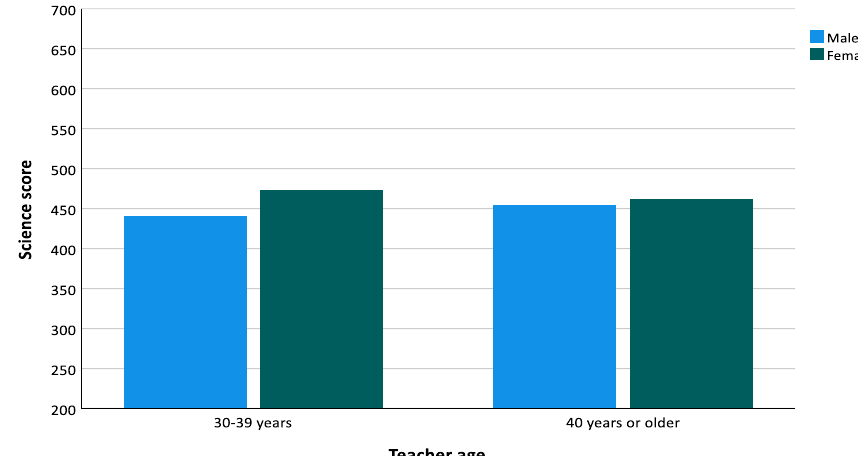
Fig. 10 Interaction between gender and teacher age on science achievement, grade 8. The plot presents the predicted values from step 7 of the science model for grade 8 (Table 11). Only the reference category and the category for which a statistically significant interaction with gender was found are